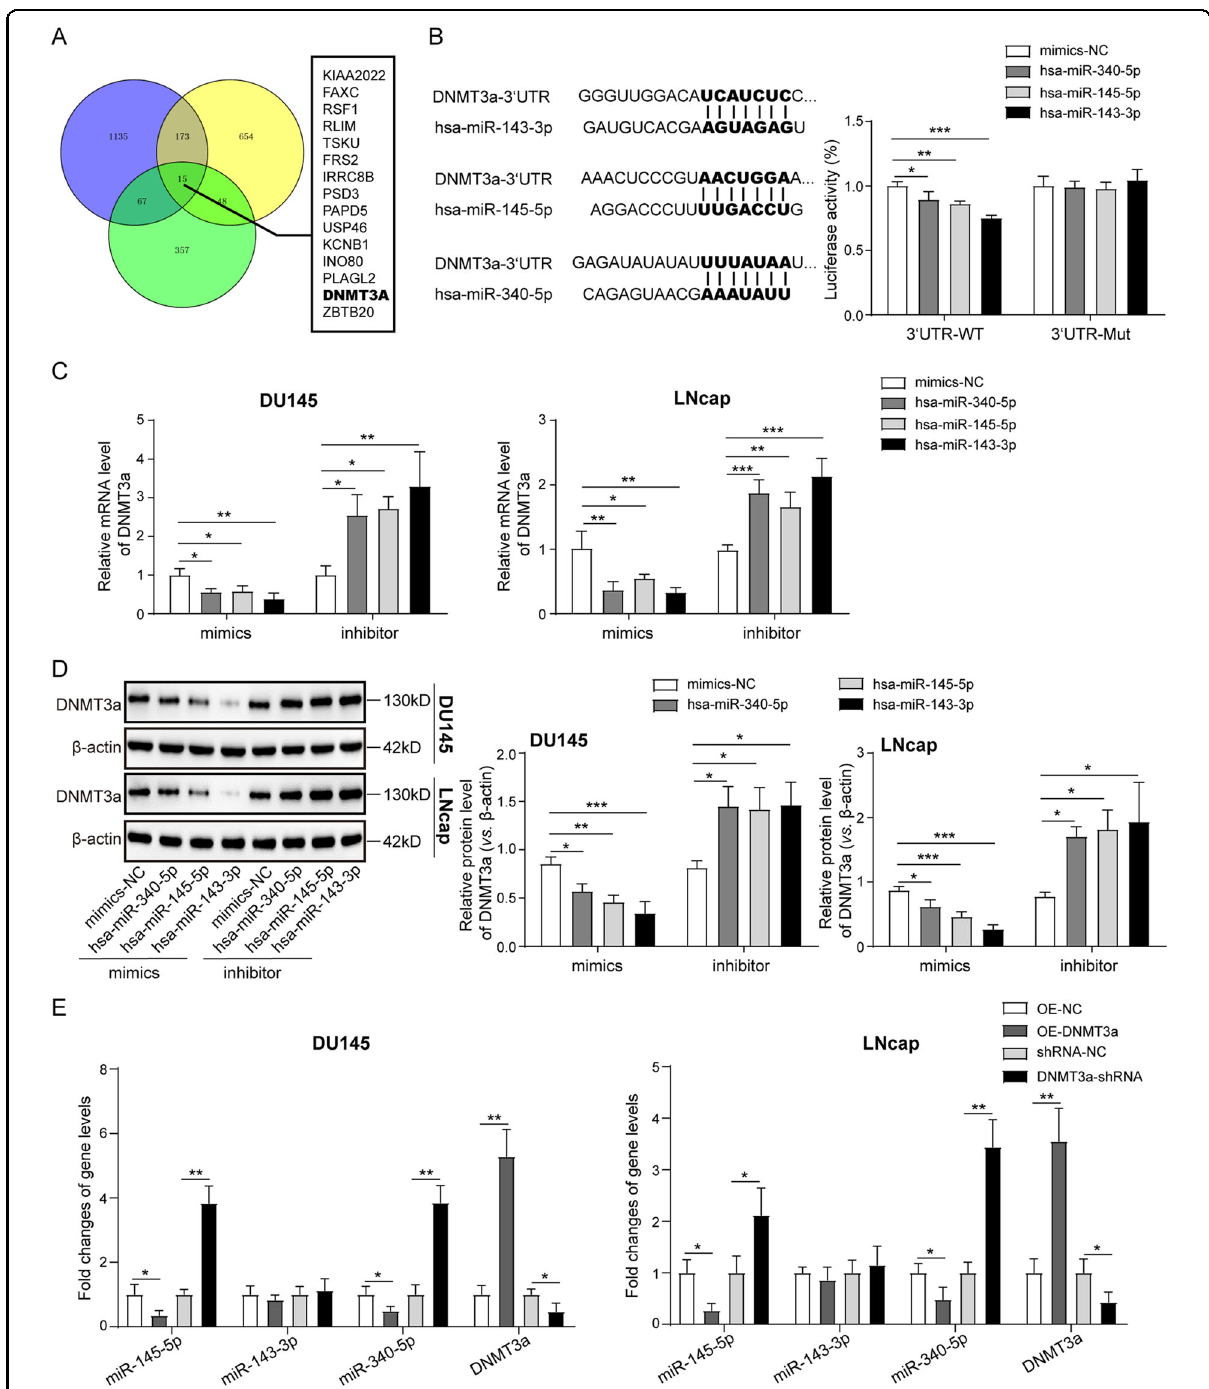
Fig. 5 DNMT3a was one of the common target genes of miR-340-5p/miR-143-3p/miR-145-5p in prostate cancer cells. A Bioinformatic prediction analysis for the common target genes of miR-340-5p, miR-143-3p, and miR-145-5p using the online software TargetScan 7.2. B Dual- luciferase reporter assay for the veri fi cation of the direct targeted binding between DNMT3a and miR-340-5p/miR-143-3p/miR-145-5p. C QPCR analysis for the expression of DNMT3a mRNA level in DU145 and LNcap cells with miR-340-5p/miR-143-3p/miR-145-5p overexpression by miRNA mimics or knockdown by miRNA inhibitors. D Western blotting analysis for the expression of DNMT3a protein level in DU145 and LNcap cells with miR-340-5p/miR-143-3p/miR-145-5p overexpression by miRNA mimics or knockdown by miRNA inhibitors. E QPCR analysis for the expression of miR- 340-5p, miR-143-3p, miR-145-5p, and DNMT3a mRNA in DU145 and LNcap cells with DNMT3a overexpression or knockdown. The results are presented as the mean ± SD. * P < 0.05, ** P < 0.01. DNMT DNA